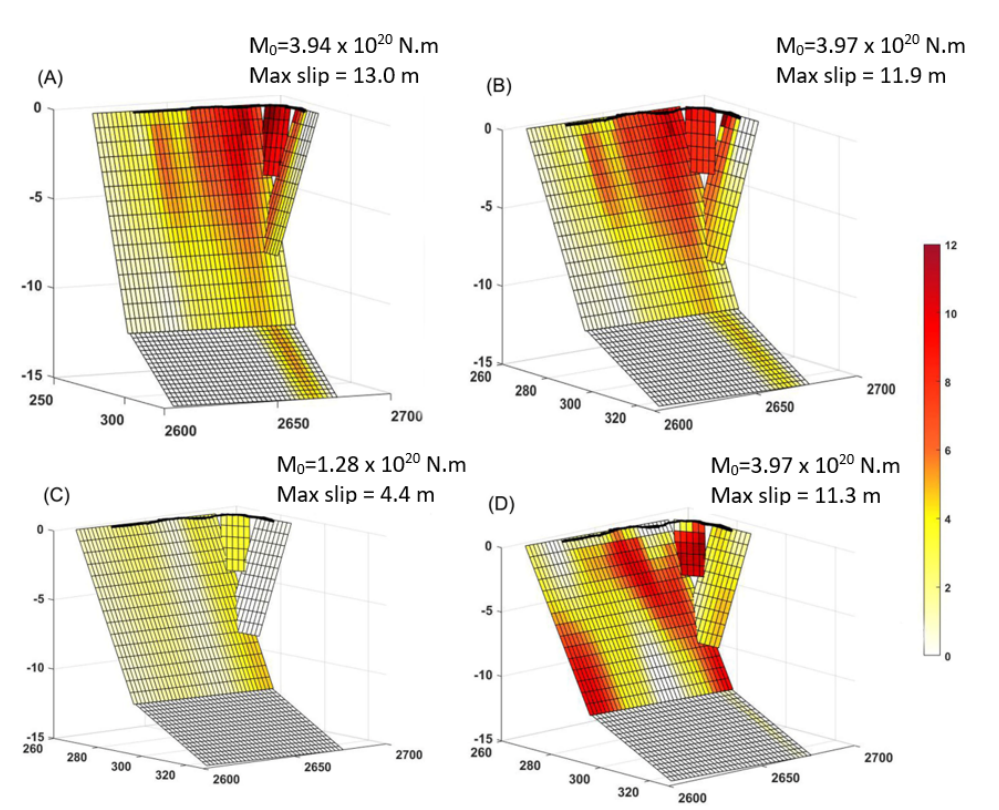
Figure 8. Slip distribution model for 4 sub-faults geometry for the Chelungpu fault (scale bars in m). Inversion (Correlation coefficient, RMS (m)) based on ( A ) GPS only (0.96, 0.39); ( B ) GPS, benchmarks and levelling (0.57, 3); ( C ) One interferogram (15 July 1999) (0.90, 0.03); ( D ) SPOT offset only (0.91, 0.90). The colour scale saturates at 12 m. M 0 is the total seismic moment for each